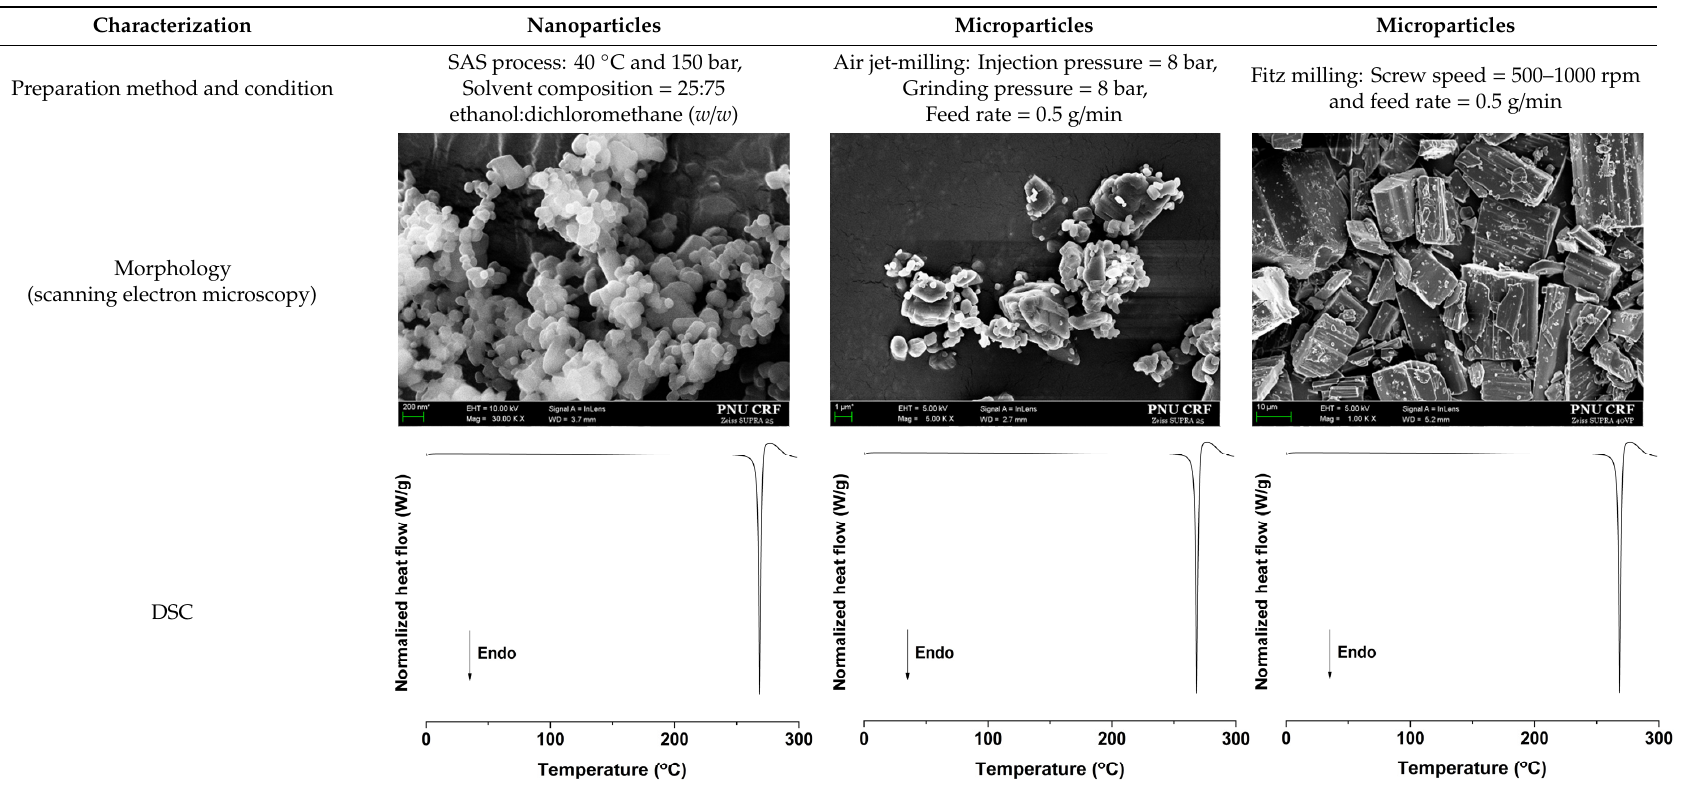
Table 2. Physicochemical properties of trans ‐ resveratrol nanoparticles and microparticles used to investigate the effect of particle size on the dissolution and oral